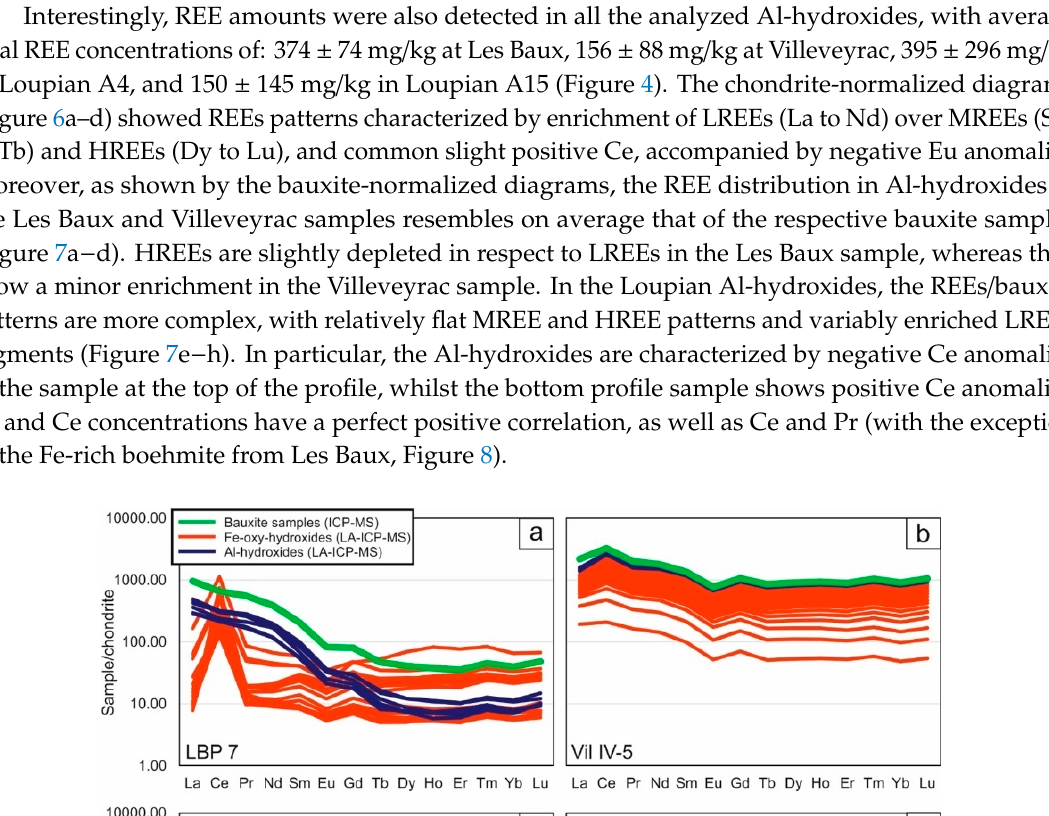
Figure 6. REE concentrations obtained on bulk bauxite samples and in-situ LA-ICP-MS analysis of Al- and Fe-(oxy)-hydroxides normalized to chondrite [33]: ( a ) Les Baux-de-Provence; ( b ) Villeveyrac; Loupian: samples at the ( c ) top and at the ( d ) bottom of the profile.